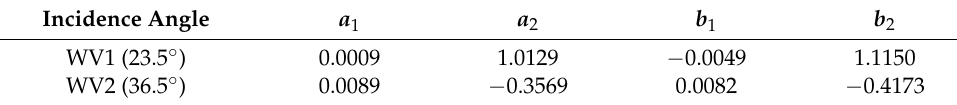
Table 2. Correction